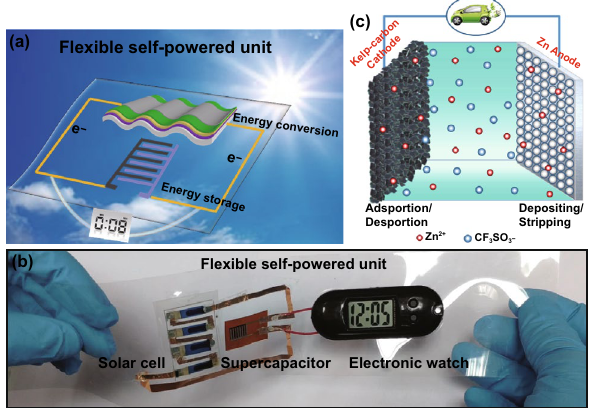
Fig. 1 a Graphical illustration of the solar-charging self-powered unit. b Proof-of-concept demonstration of the flexible solar-charging self-powered unit. c Working mechanism of the developed